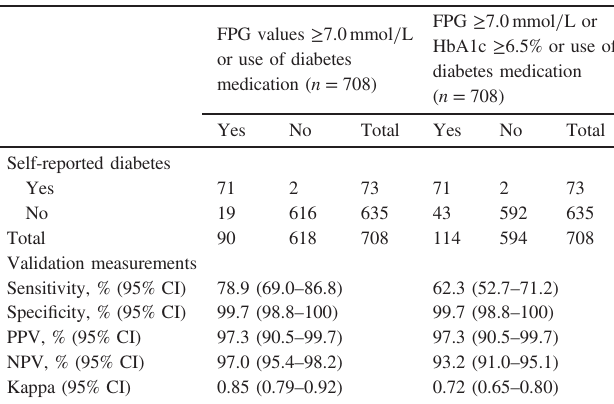
Table 5. Comparison for the validity of self-reported diabetes without or with HbA1c test ( n = 708)